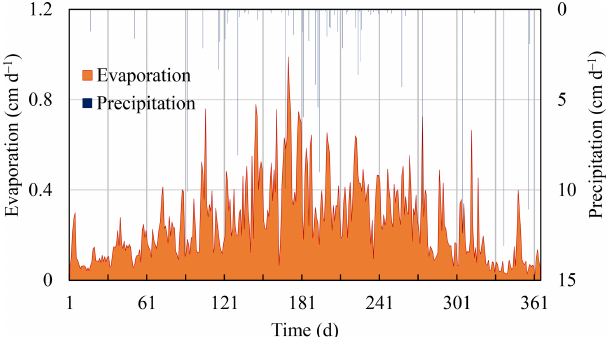
Figure 3. Rapidly changing atmospheric upper boundary conditions for scenario 2, case